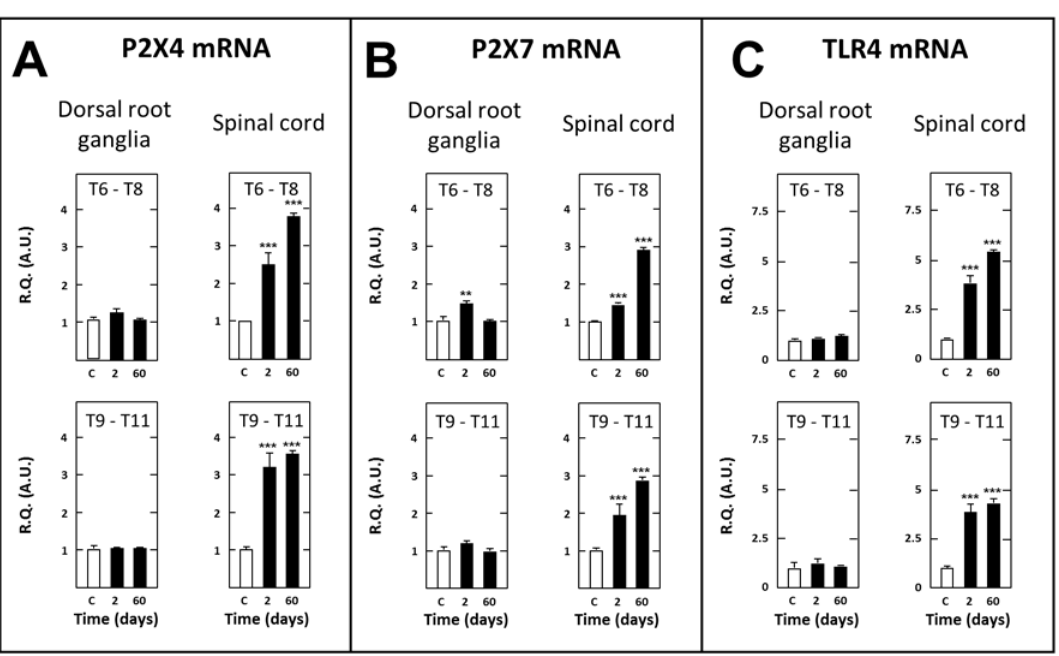
Fig 9. Short- and long-term changes in levels of transcripts encoding P2X4 (A), P2X7 (B) and TLR4 (C) in dorsal root ganglia and spinal tissues in spinal cord-transected rats. Real-time RT-qPCR determinations were made in T6 – T8 and T9 – T11 dorsal root ganglia and T6 – T8 and T9 – T11 spinal segments at day 2 or 60 (abscissa) after spinal cord transection at T8 – T9 level. Data are expressed as the ratio of specific mRNA over GaPDH mRNA [R.Q. (A.U.)]. Each bar is the mean + S.E.M. of n independent determinations (D2: n = 6; D60: n = 12). Sham values at every postoperative time are pooled under “ C ” (control) on abscissa. ** P < 0.01, *** P < 0.001 compared to respective levels in sham-operated rats (C). Two-way ANOVA followed by Bonferroni test.